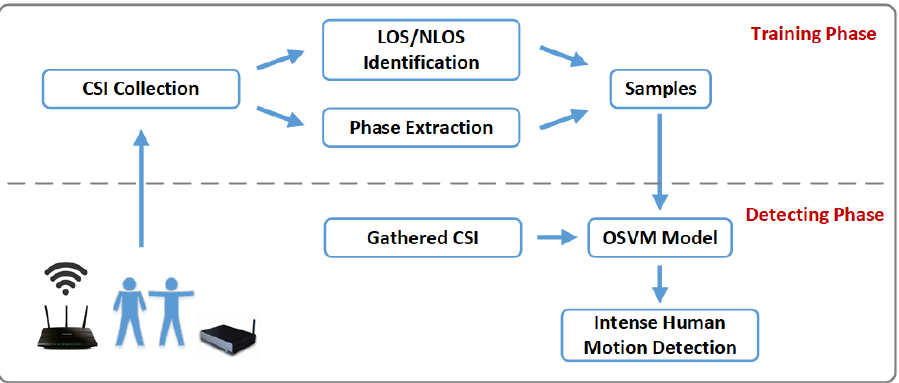
Figure 1. The framework of the intense human motion detection